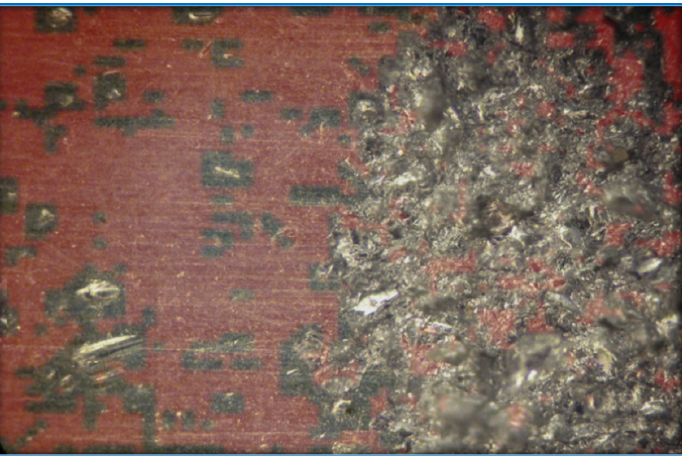
Figure 9. Marking of insufficiently processed surfaces, using the index, ω , in Equation (9).